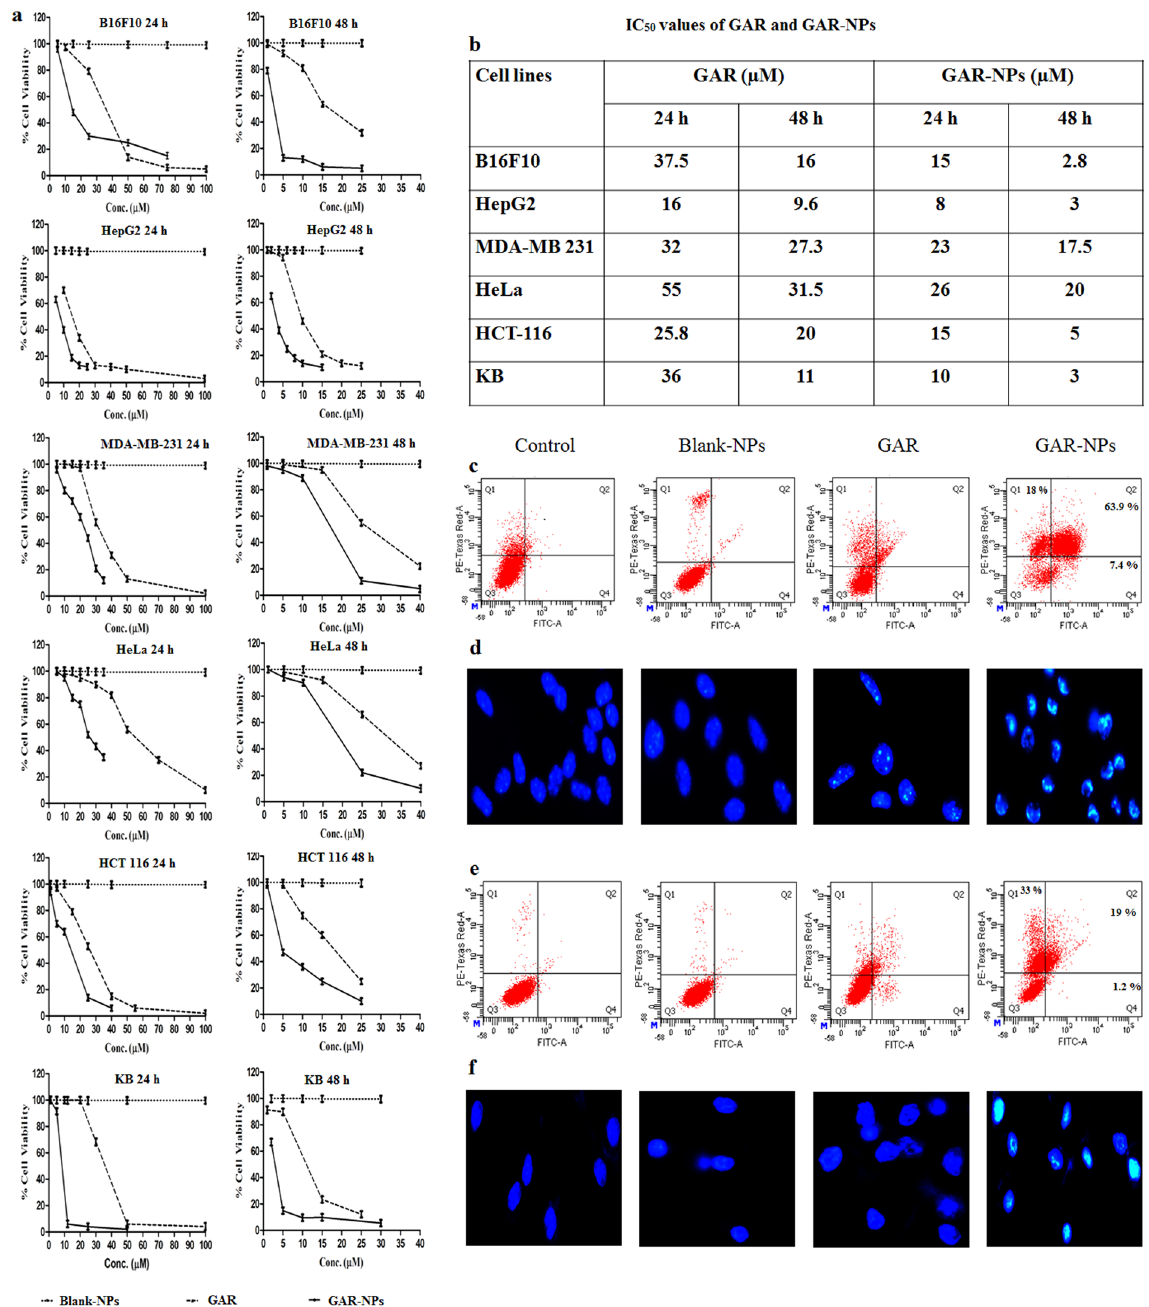
Figure 4. ( a ) Dose dependent cytotoxicity study results of GAR, blank-NPS and GAR-NPs against different cancer cell lines, ( b ) IC 50 values of GAR and GAR-NPs obtained during MTT assay at 24 h and 48 h. Flow cytometer analysis of cell apoptosis using annexinV-FITC and PI staining in ( c ) B16F10 melanoma cells and ( e ) KB cells. DAPI staining showing bright fluorescence due to condensed chromatin (apoptotic condition) in ( d ) B16F10 melanoma and ( e ) KB